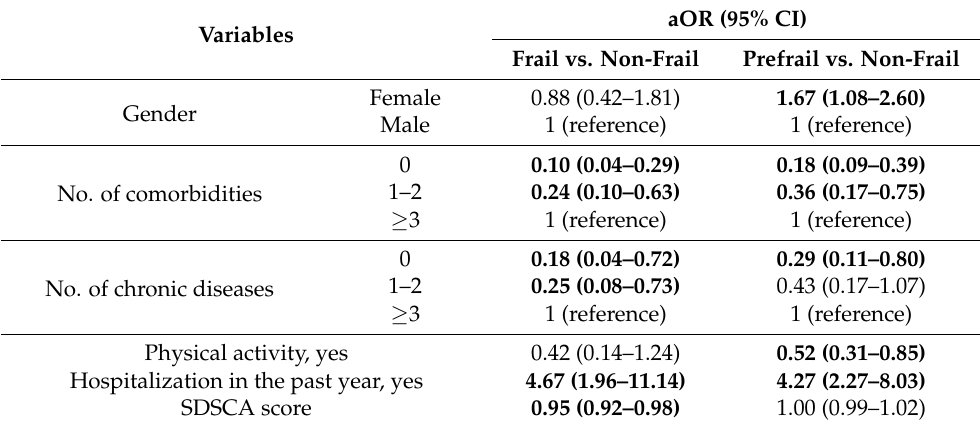
Table 4. Odds ratios from multinomial logistic regression for frailty and